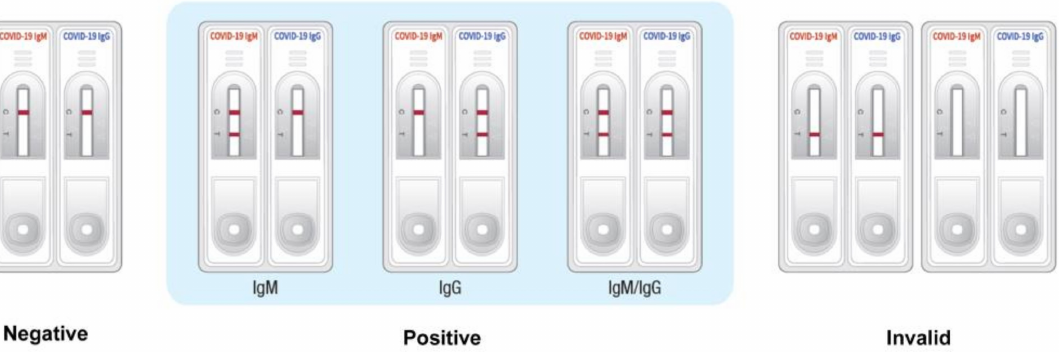
Figure 3. Interpretation of the test results of the rapid diagnostic test (RDT) strip.